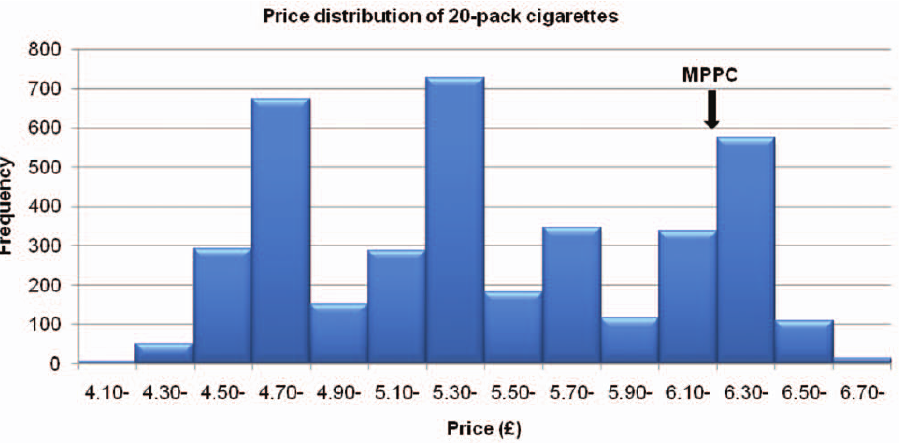
Figure 2. Price distribution of 20-pack cigarettes.